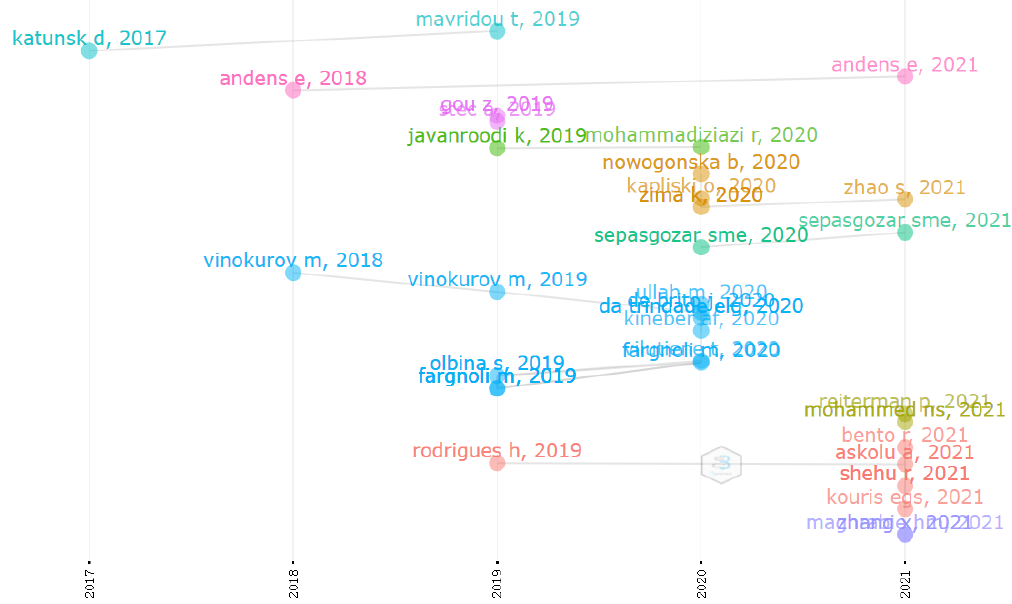
Figure 9. Historical direct citation network.